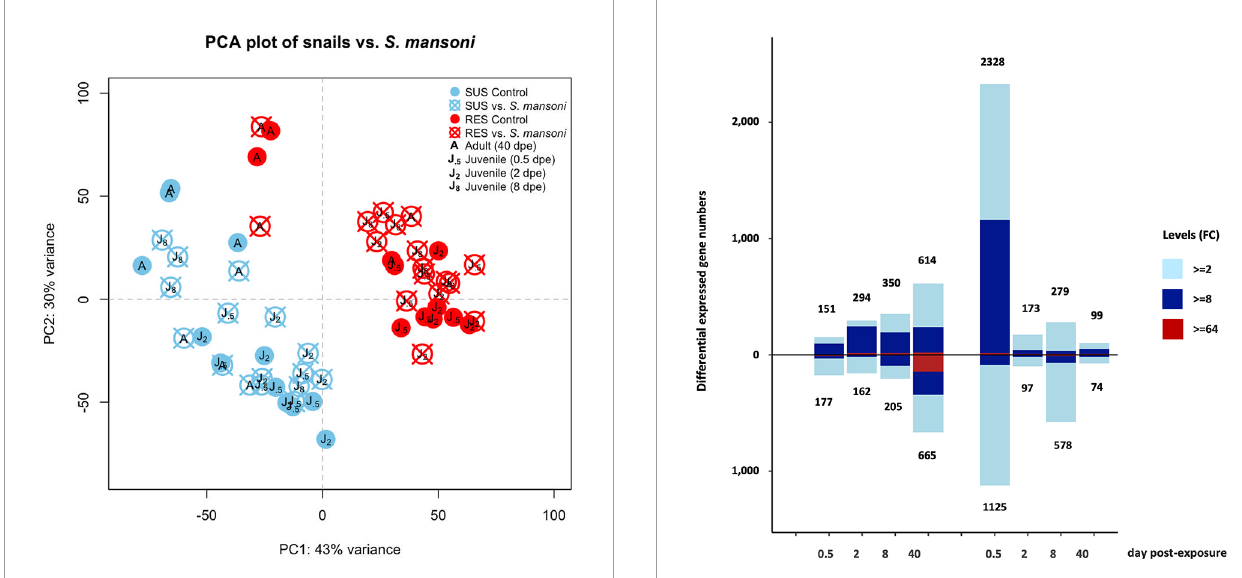
FIGURE 5 | Principal components analysis (PCA) plot indicating the eight groups of snails exposed to S. mansoni examined in this study. Results for SUS unexposed snails are shown in light blue closed circles and snails exposed to Sm in light blue crossed circles. RES designations were similar but shown in red. “ J .5 ” refers to juvenile snails matched in size and time to snails exposed to Sm for 0.5 days, “ J 2 ” and “ J 8 ” refer to juveniles matched to snails exposed to Sm for 2 or 8 dpe, respectively, and “ A ” refers to adult snail size and time matched to snails with patent infections of Sm (~40